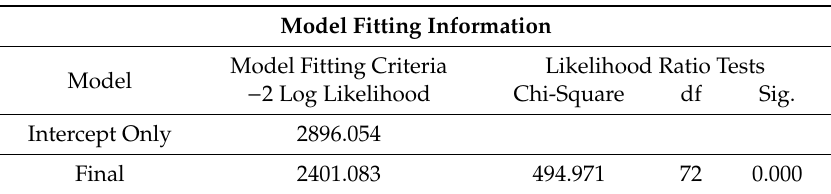
Table 4. Model fitting test for logistic regression of negative attitude of parents towards vaccines formed on the basis of information from online